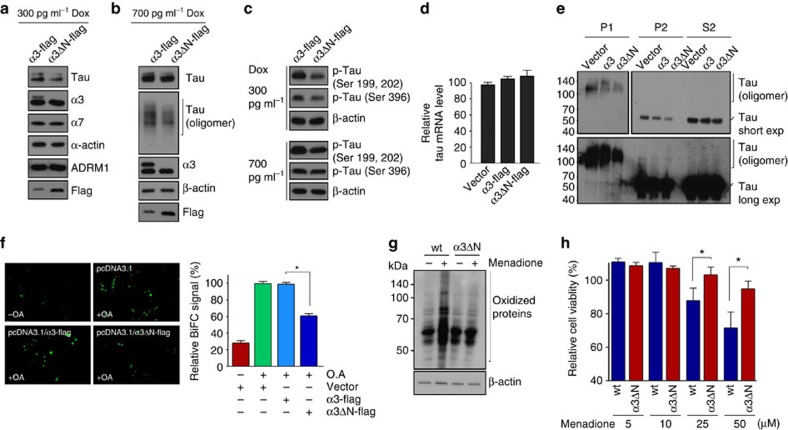
Facilitated tau protein degradation and delayed tau aggregation by
α3ΔN gate opening.(a) Total tau proteins were detected after expression of wt
α3 and α3ΔN in the inducible tau cell line
treated with 300 pg ml−1
doxycycline (Dox). (b) Same as a, except that
700 pg ml−1 Dox treatment
was used to detect aggregated forms of tau. When α3ΔN
was coexpressed, levels of tau oligomers were significantly decreased.
(c) Inducible tau cell lines were treated with
300 pg ml−1 (upper panel)
and 700 pg ml−1 Dox (lower),
indicating α3ΔN gate opening enhances the degradation of
phosphorylated tau proteins as well. Samples were analysed by immunoblotting
using phosphorylation-specific tau antibodies (Ser 396 and Ser 199/202).
(d) qRT–PCR to compare tau mRNA levels in the inducible
tau cell lines after transfection and
300 pg ml−1 Dox
treatment. (e) Same as a, except tau was induced by
500 ng ml−1 Dox, and tau
in SDS-soluble and -insoluble fractions were separately isolated and
compared (see Methods). P1, P2 and S2 denote pellets after 200g,
pellets after 16,000g and supernatants after 16,000g
centrifugation runs, respectively, using Triton X-100-based lysis buffer.
Short exp and long exp, short and long exposure of the blot, respectively.
(f) Comparison of tau oligomerization after tau-BiFC cell lines
were transfected with α3 or α3ΔN. Values
represent the mean (±s.d.) of three independent cultures
including a total of ∼10,000 cells. OA, okadaic acid. (g)
Wild-type (wt) and α3ΔN cell lines were treated with
menadione (25 μM) for 2 h. Oxidized proteins in
whole-cell lysates were labelled with 2-4-dinitrophenyl hydrazine (DNPH),
and immunoblotting with anti-dinitrophenyl (DNP) antibody was performed.
(h) Cell survival under oxidative stress was measured using wt
and α3ΔN cells. Menadione was treated as the indicated
concentrations for 4 h. Values are represented as
mean±s.d. (n=3). *P<0.01
(one-way analysis of variance (ANOVA) with Bonferroni's multiple
comparison test).